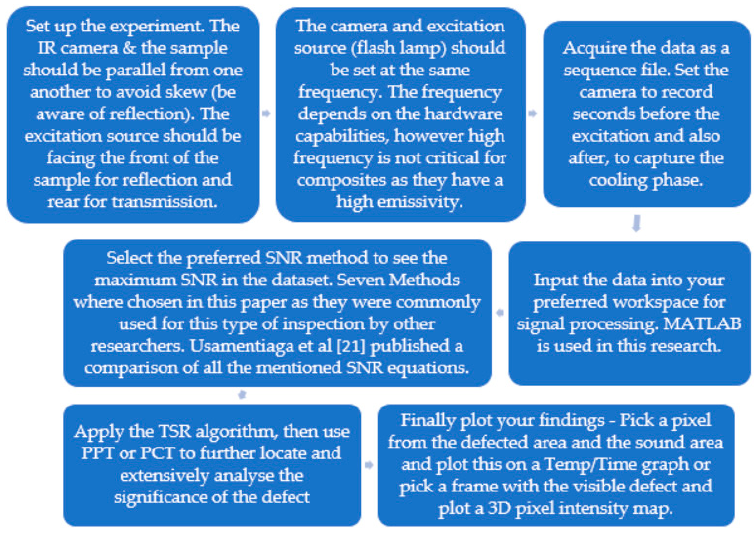
Figure 6. The method strategy according to an active thermographic test.